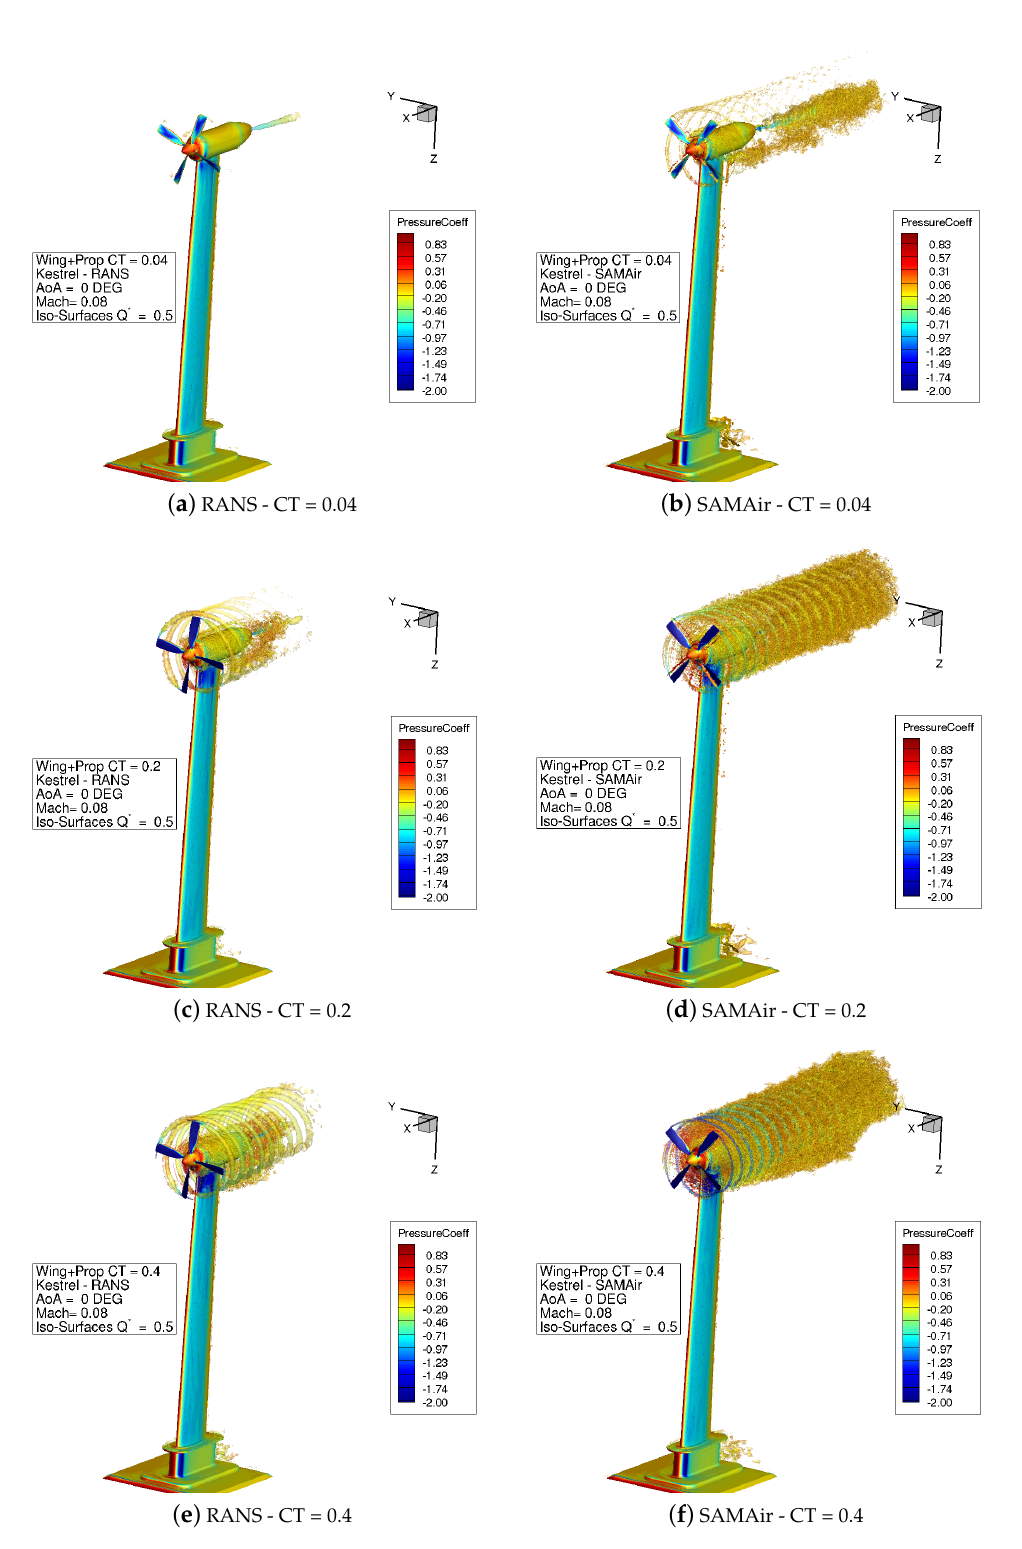
Figure 16. Flow solutions of the wing propeller at different thrust